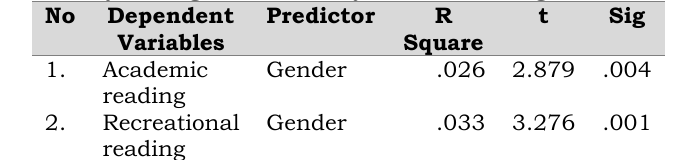
Table 3. Summary of Regression Analysis for Reading Attitude Dimensions No Dependent Predictor Variables